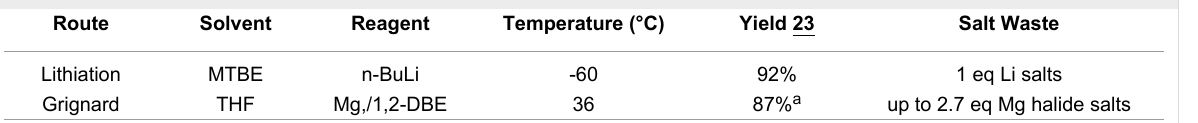
Table 2: Lithiation vs. Grignard Manufacturing Issues for the Preparation of 3,4,5-Trichloro-2-thiophenecarboxylic Acid 23 Route Solvent Reagent Temperature (°C) Yield 23 Salt Waste Lithiation MTBE n-BuLi -60 92% 1 eq Li salts Grignard THF Mg,/1,2-DBE 36 87% a up to 2.7 eq Mg halide